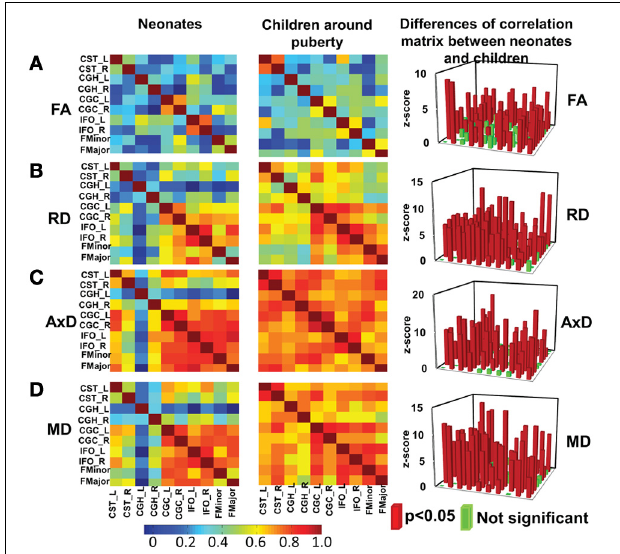
FIGURE 4 | Heat maps of the inter-tract correlation matrices obtained from tract-level FA (A), RD (B), AxD (C) and MD (D) measurements of both age groups. The left and middle panels show the inter-tract correlation matrices for neonates and children around puberty, respectively. The right panel shows the z -scores of the changes in correlation strength between the two age groups. In the z -score plots, the entries with significant ( p < 0 . 05) changes in inter-tract correlation strengths are shown in red color while entries with non-significant ( p > 0 . 05) change in inter-tract correlation strengths are shown in green color. Color bar encoding the correlation strengths in the left and middle columns is also shown.